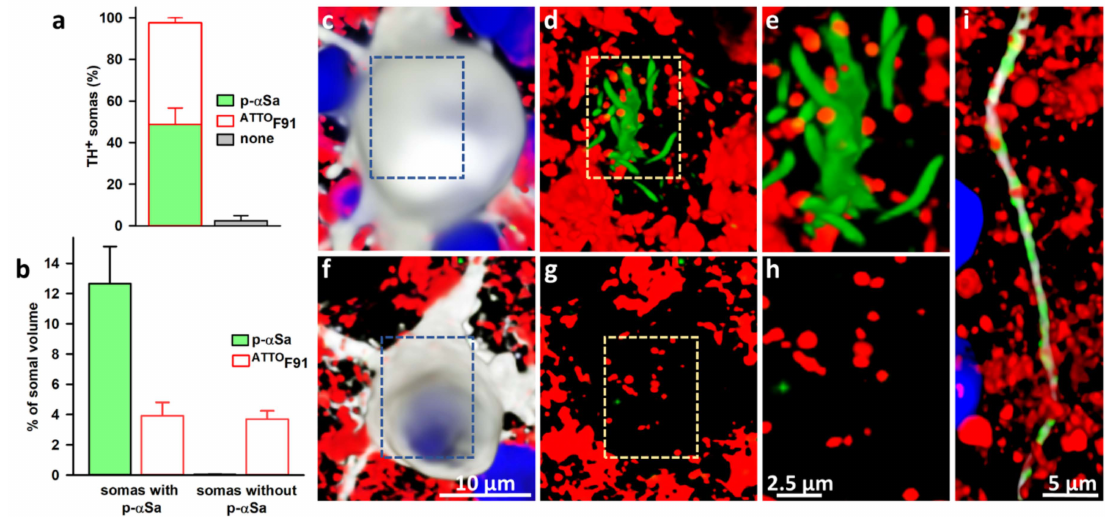
Figure 6. Subcellular monitoring of α S seeded aggregation in DA neurons with fluorescently labelled fibril seeds. ( a ) In three-week midbrain cultures exposed to ATTO F91 (0.5 µ M) two weeks earlier, fibrils are detectable in most of TH + cell somas. The efficacy of ATTO F91 to seed aggregation of endogenous α S in DA neurons is similar to that of unlabeled F91. ( b ) Volume occupied by p- α Sa and ATTO F91 in DA cell somas with or without large somal aggregates. ( c ) 3D projection of a confocal image stack showing a DA (TH + ) cell body (light grey pseudocolor for deep red fluorescence) in a three-week midbrain culture exposed two weeks earlier to 0.5 µ M ATTO F91 (red). ( d ) Corresponding 3D image where the light grey channel for TH was removed to show that this soma contains small puncta of fibril seeds (red) and a large filamentous inclusion of p- α S (green). Some of the fluorescent puncta (red) seem to decorate the serpentine-like elements of the inclusion (green). ( e ) Enlarged view of the section delimited by the dotted line rectangle in ( d ). ( f ) 3D projection of a DA (TH + ) cell body (light grey) in a midbrain culture exposed two weeks earlier to 0.5 µ M ATTO F91 (red). ( g ) Corresponding image without the light grey channel to show that this soma contains ATTO F91 puncta but no large inclusion of p- α S. ( h ) Enlarged view of the section delimited by the dotted line rectangle in ( g ). ( i ) 3D projection image showing that ATTO F91 puncta (red) are juxtaposed with elongated p- α S structures (green) along TH + neurites (light grey) in a DA neuron containing a somal inclusion. Nuclear counterstaining with Hoechst-33342 (H; blue) was removed from ( d , e , g , h ) to allow for better visualization of somal fibril